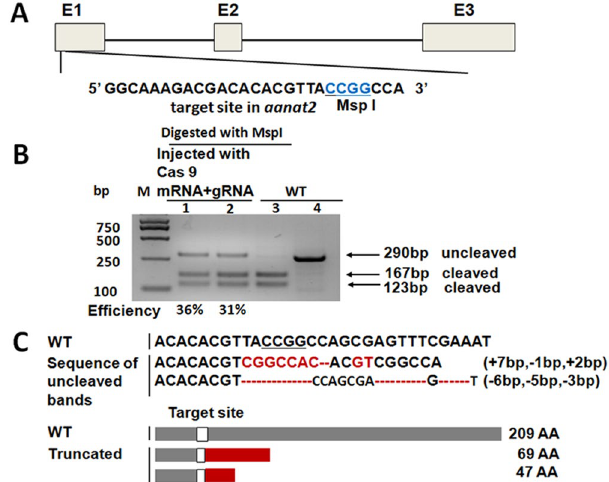
Figure 1. Generation of aanat2 mutant zebrafish using CRISPR-Cas9. ( A ) Schematic of the Cas9-gRNA- targeted site in the first aanat2 exon. The protospacer-adjacent motif (PAM) sequence (CGG) is labeled in blue and the MspI restriction site is underlined. ( B ) The targeted fragment was PCR-amplified from pooled genomic DNA of 15 embryos co-microinjected with 300 pg Cas9 mRNA and 100–200 pg gRNA, and then digested with MspI. The uncleaved (290 bp) and cleaved PCR products (167 bp and 123 bp) were indicated. Mutagenesis efficiencies were calculated by the ratios of intensities of uncleaved bands to the sum of cleaved bands using Image J software. M, marker: 1–2, injected groups at concentrations of 100 pg and 200 pg of aanat2 gRNA, respectively; 3, wild-type control with digestion of MspI; 4, undigested wild-type PCR products. ( C ) Representative sequencing results of the two mutated fish lines. One had a 9-bp insertion and a 1-bp deletion, the other had a 14-bp deletion (upper), and both lines had frameshift mutations that resulted in truncated proteins (lower). AA, amino acids.